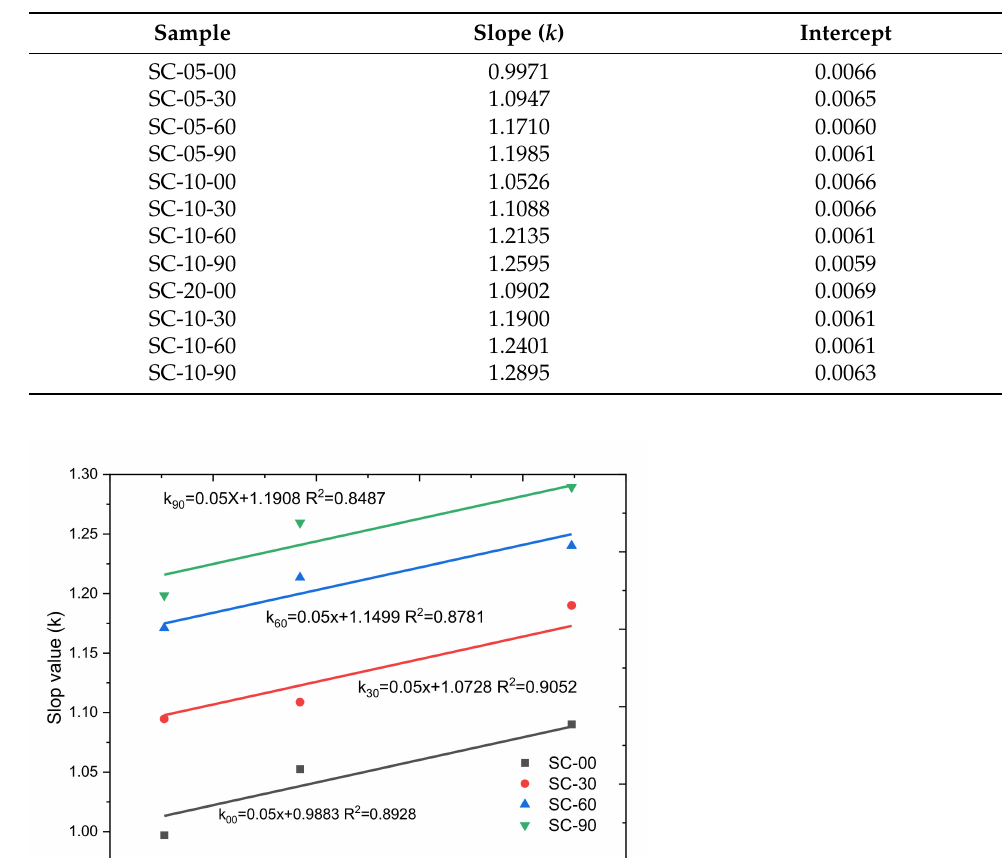
Table 4. Linear fitting parameters.